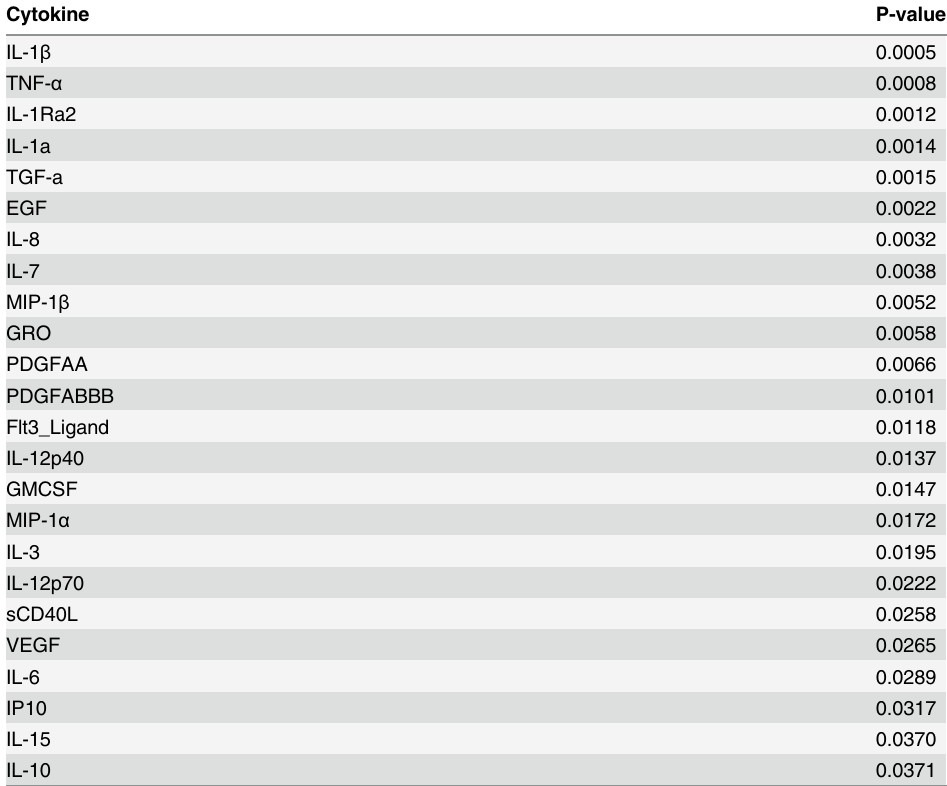
Table 1. Statistically significant cytokines with oseltamivir-associated reductions in the nasal wash, adjusted by viral